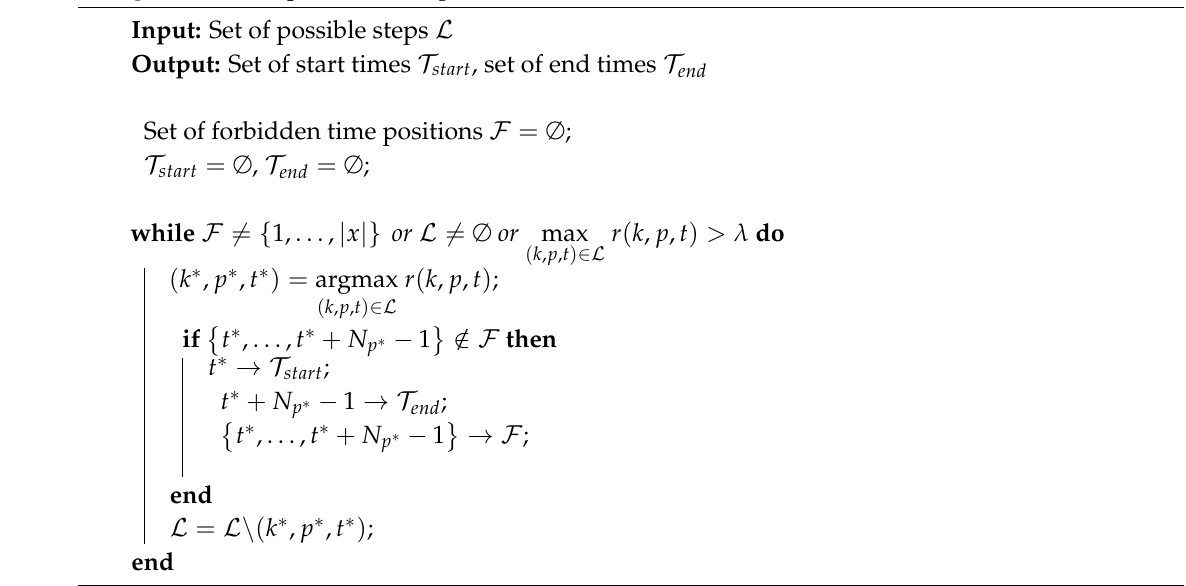
Algorithm 1: Step detection